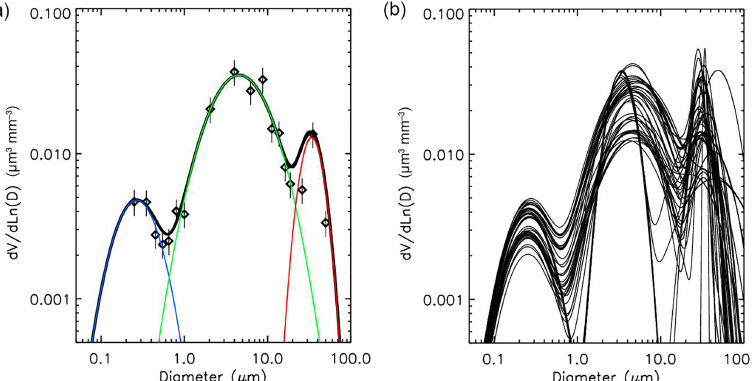
Figure 15. (a) Example of particle volume size distribution within the desert dust plume from the BLPB flight of 19 June 2013 at an altitude of 3.3km, from one measurement at 12:30UT. The black diamonds are the LOAC measurements (with 1 σ error bars), the coloured curves represent the lognormal functions for each of the observed modes, and the black curve represents the overall fit (sum of the 3 modes). The geometric mean diameters (Dm) of the 3 modes are of 0.27, 4.6, and 34µm, with respective geometric standard deviations ( σ ) of 1.79, 2.14, and 1.35. (b) The 41 fitted size distributions when the third mode was detected, retrieved from all measurements during the 19 June BLPB flight at float